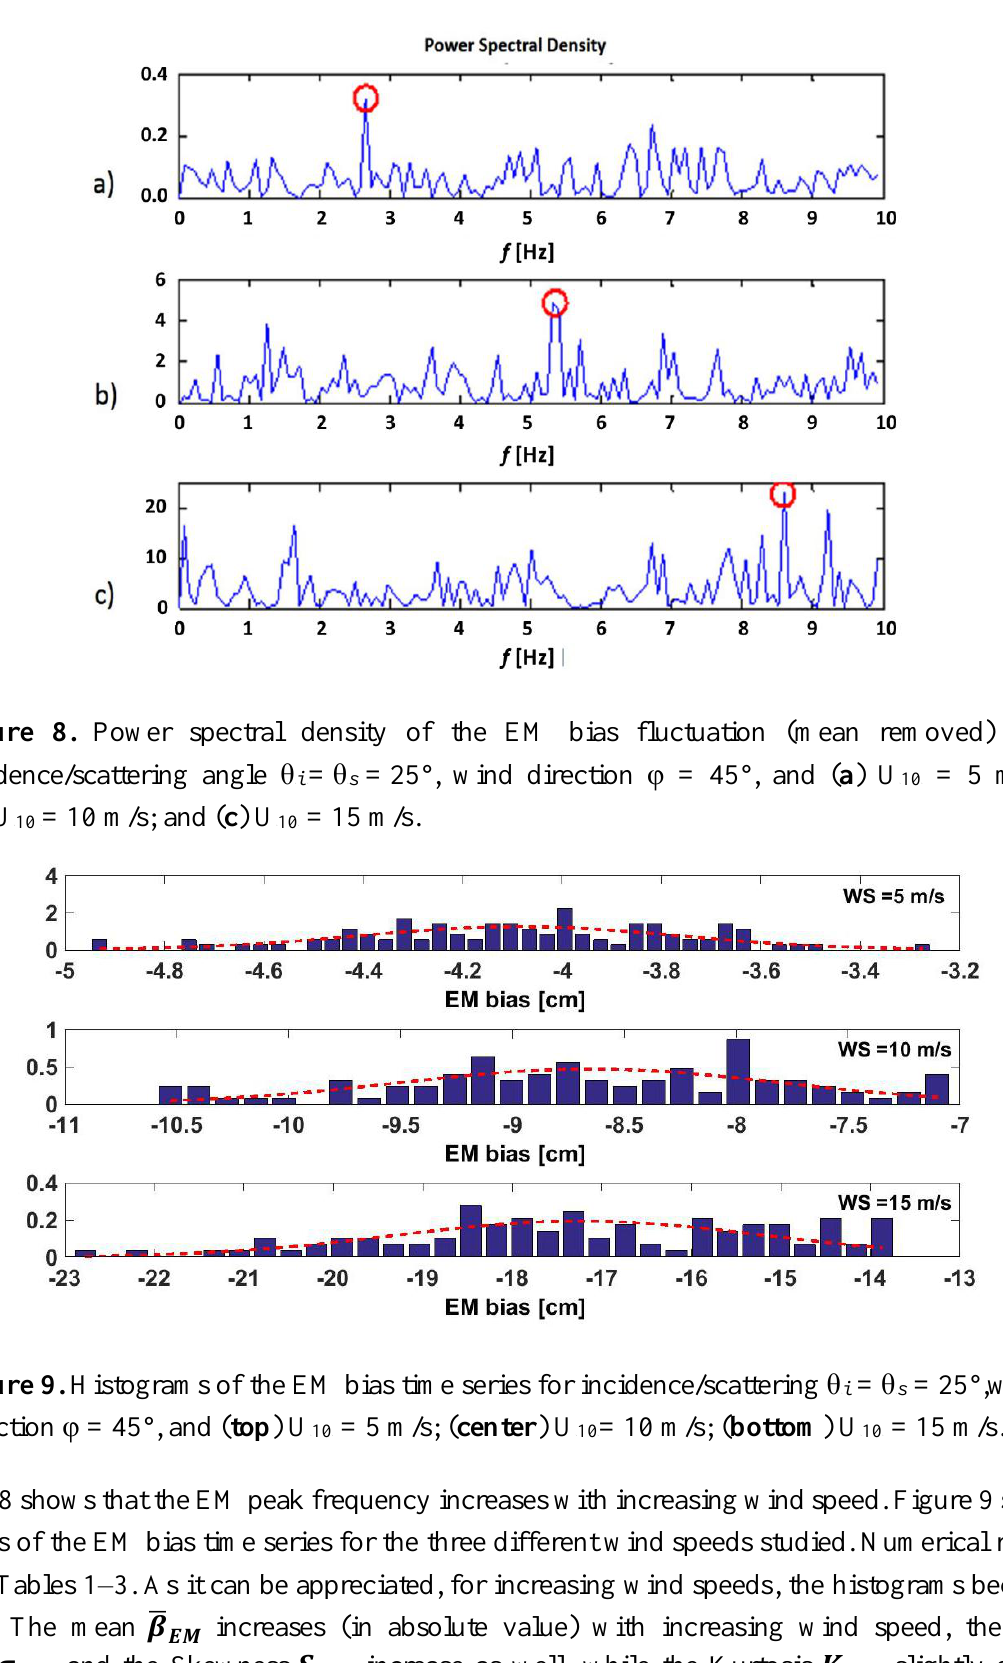
= 5 m/s; ( center ) U 10 R R